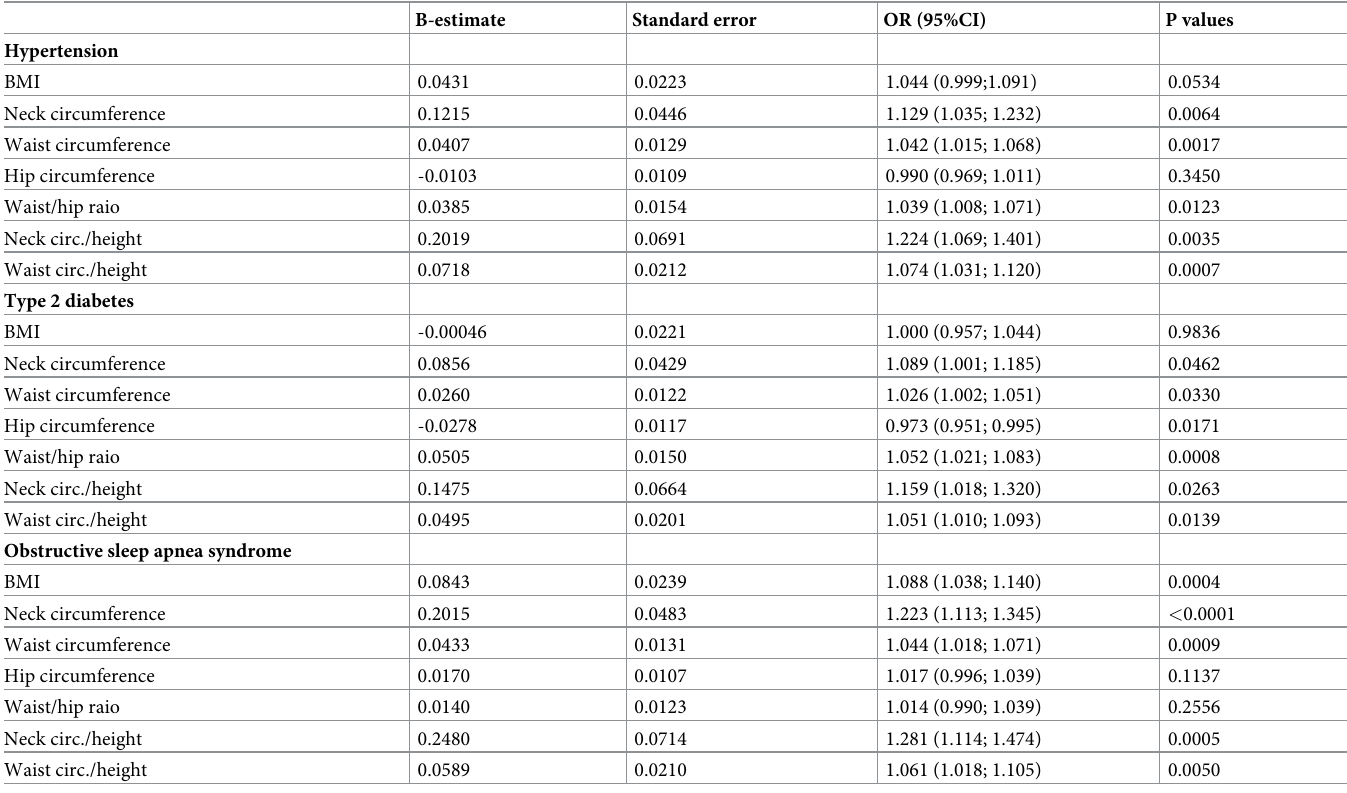
Table 3. Multivariable logistic regressions for obesity related diseases.